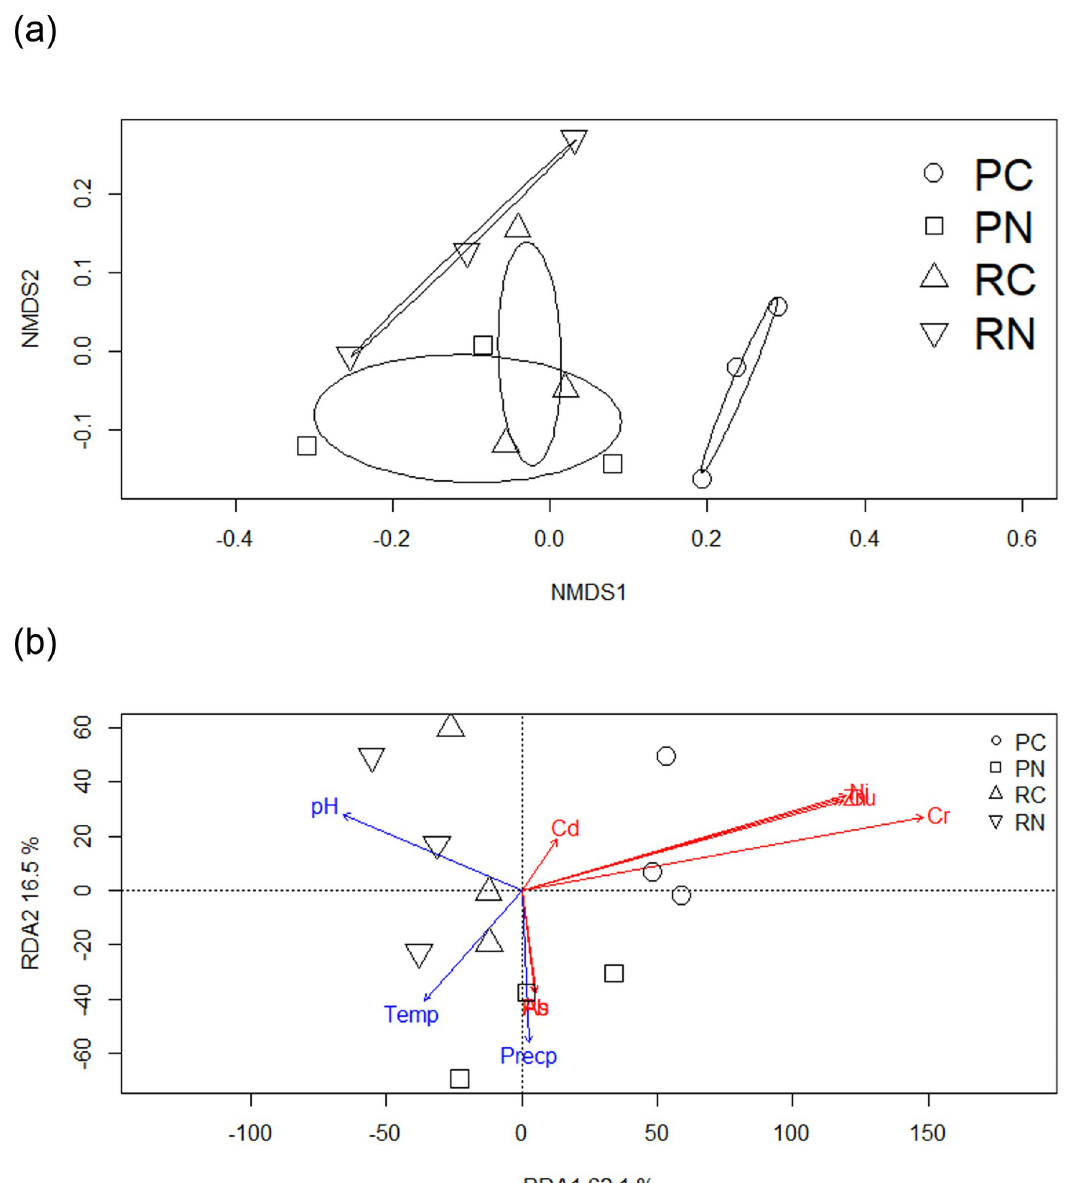
Fig 3. (A) Nonmetric multidimensional scaling (NMDS) ordination of the soil samples and (B) redundancy analysis (RDA) show the correlation among bacterial community and a subset of seven heavy metals at the phylum level. PN, Nantou polluted area; PC, Changhua polluted area; RN, Nantou remediated area; RC, Changhua remediated